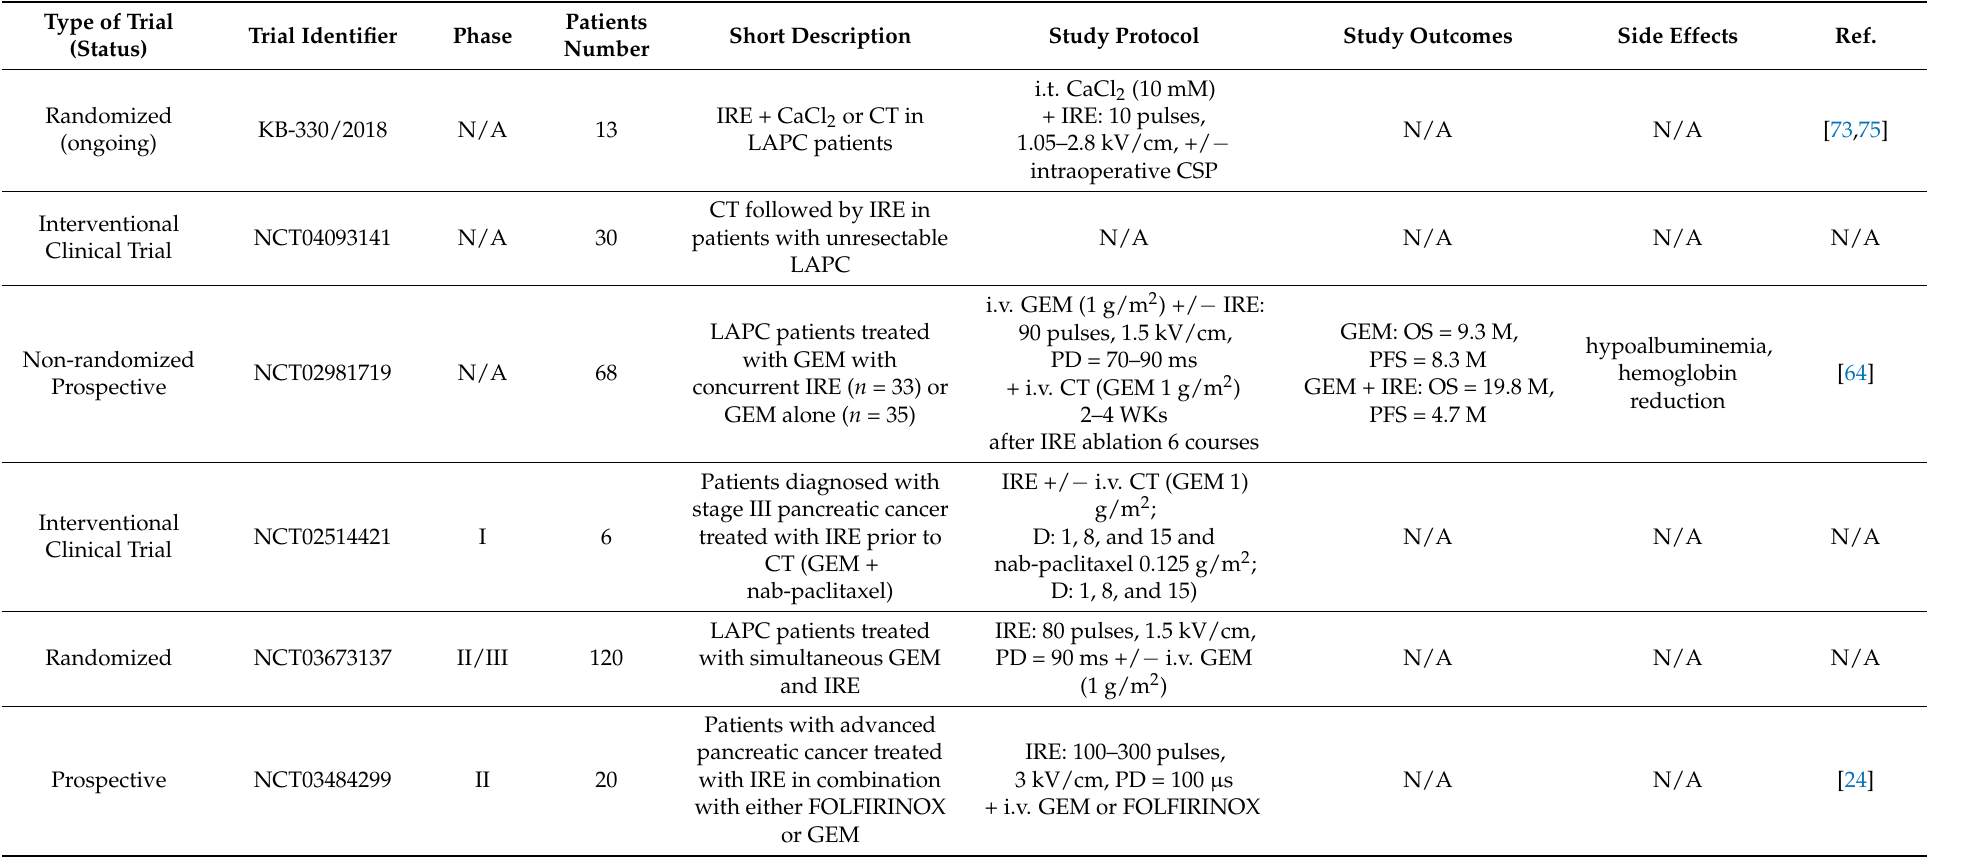
Table 2. Preclinical and clinical studies involving IRE in combination with